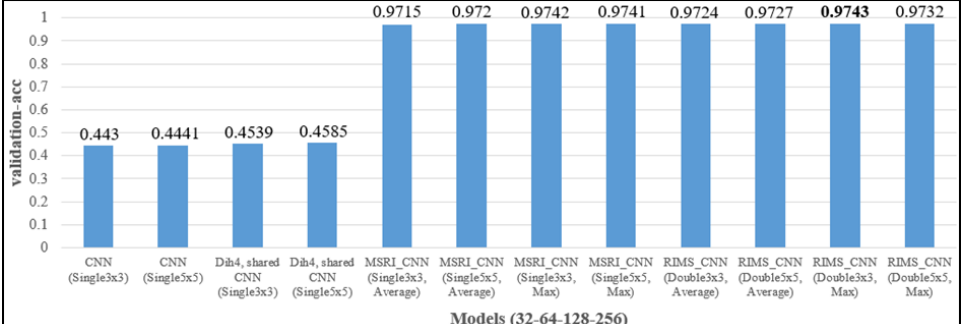
Figure 12. The results of different designs validated on the fixed-angle-rotated MNIST.